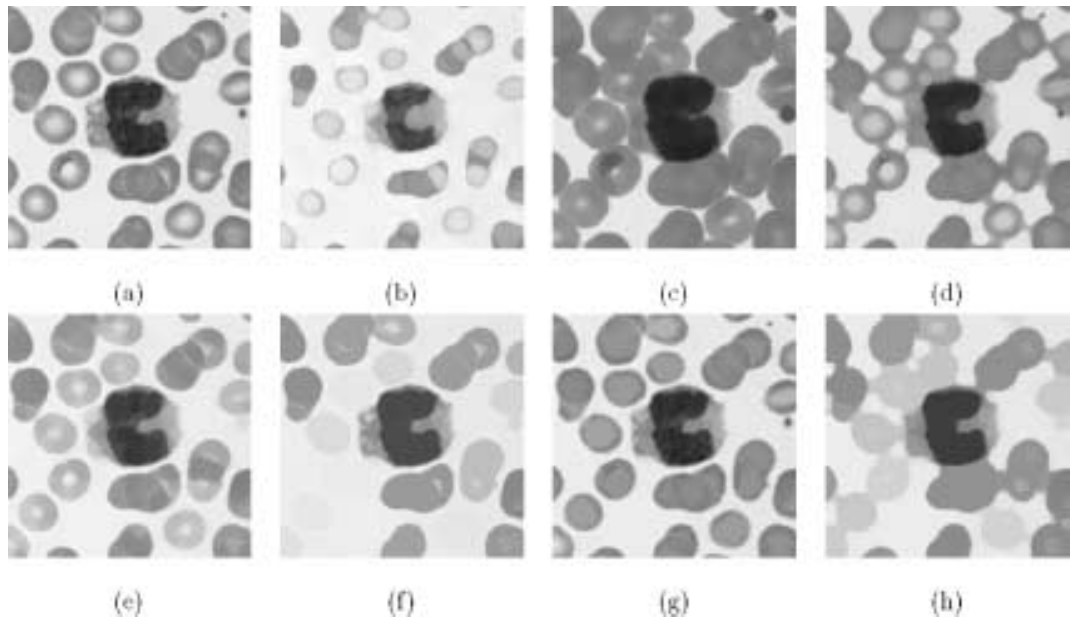
Fig. 3. Effects of morphological operators on grey-tone structures: (a) Initial image, f , (b) dilation, δ sB ( f ) (fading of dark structures and expansion of white structures), (c) erosion, ε sB ( f ) (dual effects), (d) opening, γ sB ( f ) (filter out light structures), (e) closing, ϕ sB ( f ) (filter out dark structures, in the four cases s = 10 and B is a circle), (f) closing by reconstruction, ϕ rec (using as marker a closing of size s = 20 and a dual reconstruction; the dark structures with size smaller than 20 are removed and the contours are preserved), (g) dual close-hole operator, ψ clohole ( f ) (the dual holes–light structures inside dark bordered regions – that do not touch the image boundary are filled) and (h) dual size-and-close-grain operator, ψ clogra ( f ) (dark structures smaller than a size are removed and the dark structures are